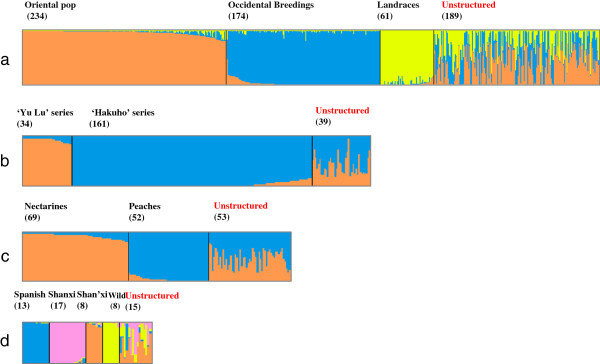
Population stratification based on Bayesian clustering approaches for K = 1 to K = 10 (Each individual is shown as a thin vertical line, different subpopulations are separated by a black line and are in different colors). a The first STRUCTURE step with 658 accessions, when K = 3. The subpopulation was displayed by DISTRUCT. Each subpopulation was ordered according to the membership coefficient. b Nested STRUCTURE analysis for the Oriental subpopulation which was further divided into two subpopulations: ‘Yu Lu’ and ‘Hakuho’. c Nested STRUCTURE analysis for the Occidental breeding subpopulation, mainly divided into ‘Nectarine’ and ‘Peach’ populations. d Nested STRUCTURE analysis for the landrace subpopulation. Note: Unstructured indicates the individuals which were not assigned to any subpopulation. The characters and numbers at the top of each population column give the name of each subpopulation and the number of individuals included.